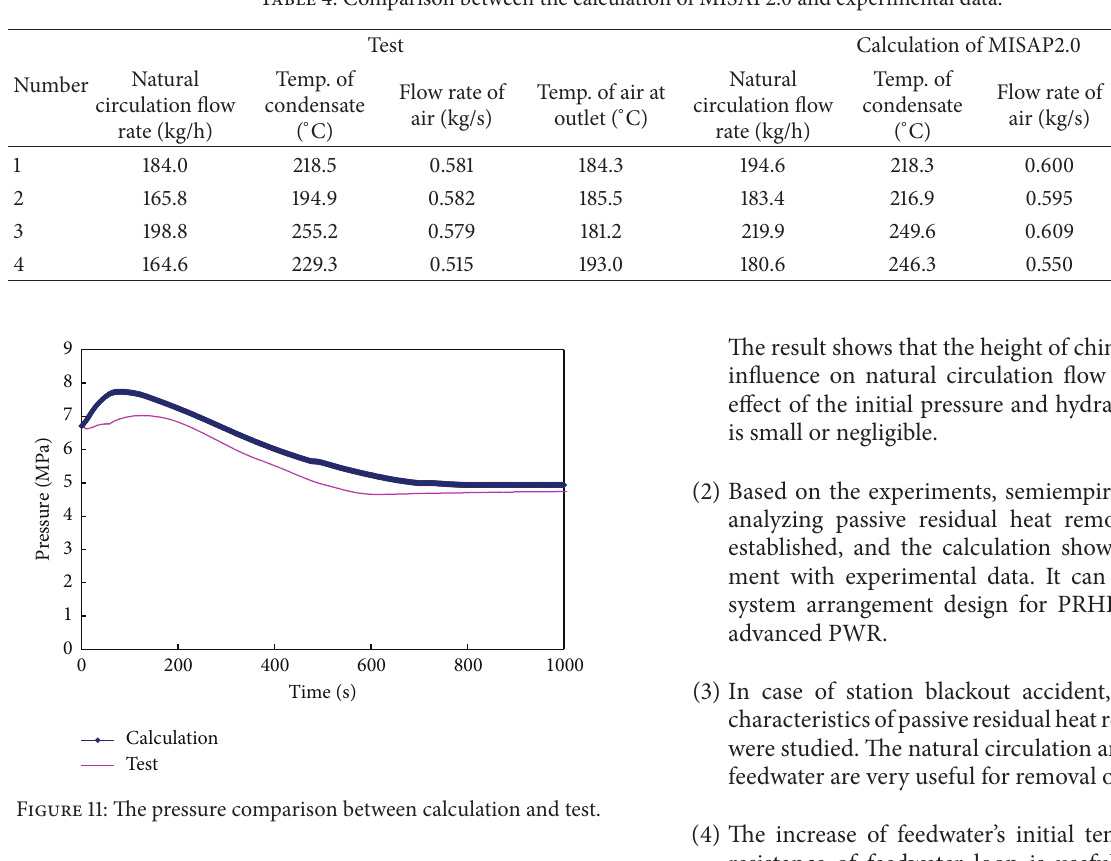
Table 4: Comparison between the calculation of MISAP2.0 and experimental data.